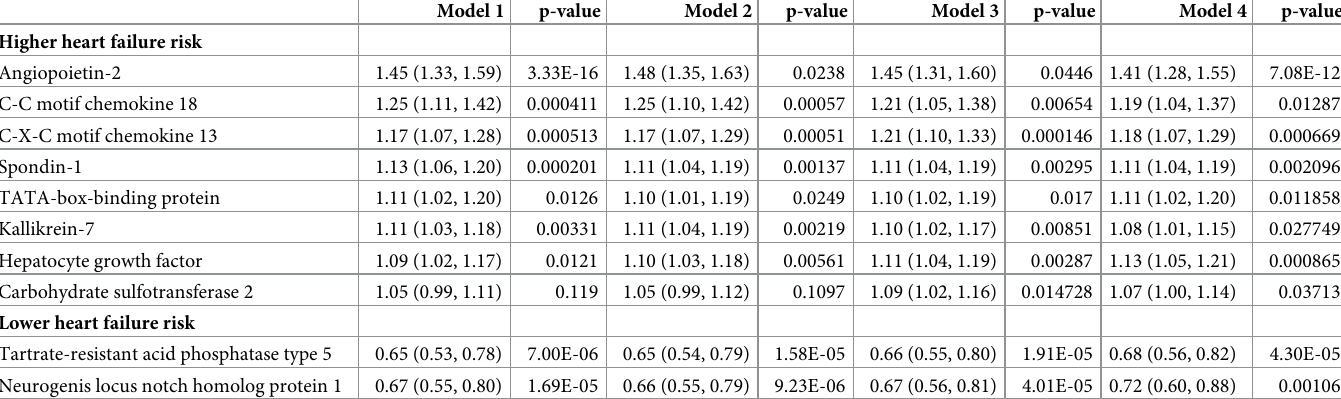
Table 2. Hazard ratios and 95% confidence interval per 1-SD predicting time to heart failure hospitalization among those with chronic kidney disease � (N = 364), heart and soul study.